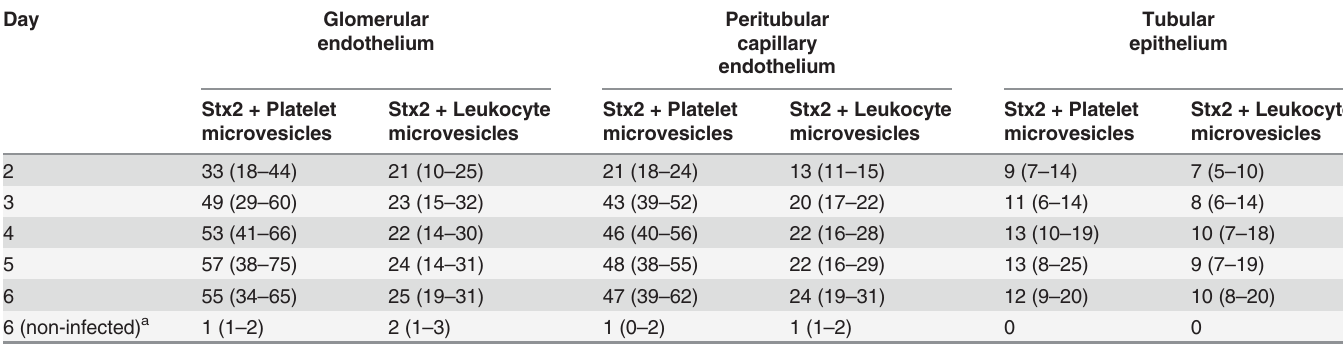
Table 2. Numbers and cellular origin of Stx-positive microvesicles in mice infected with E. coli O157:H7.